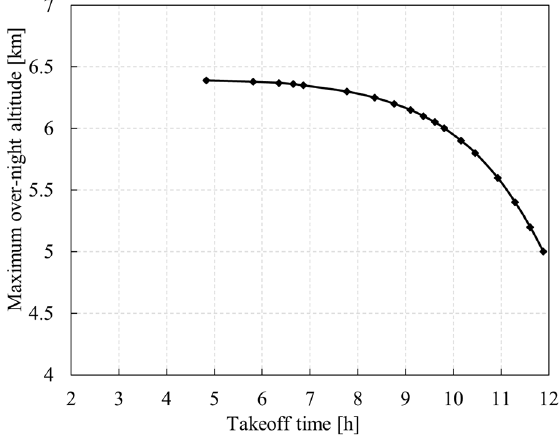
Figure 24. Variation of maximum overnight altitude with takeoff time.